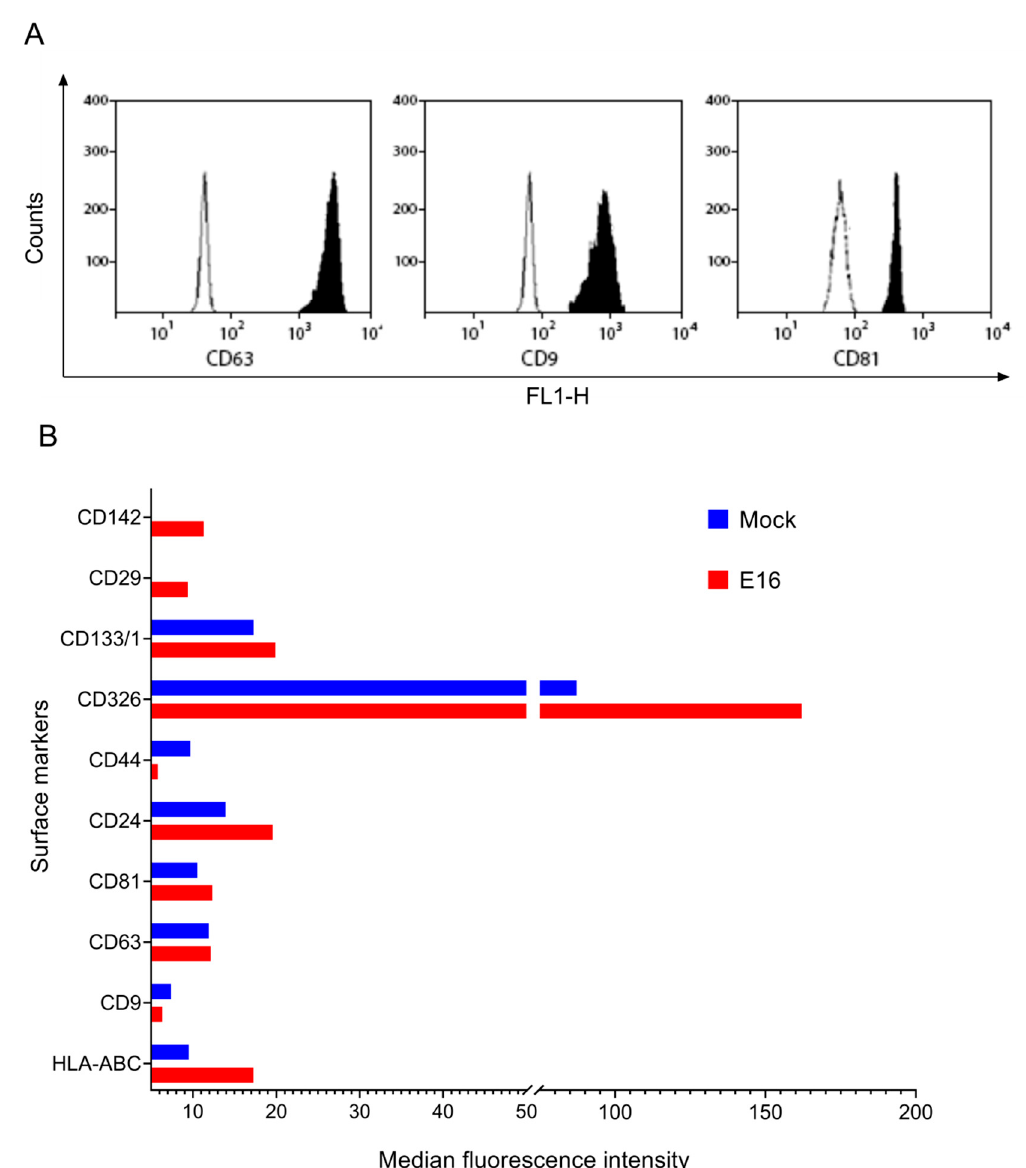
Figure 3. Phenotyping of EndoC- β H1 cell-derived EVs ( A ) Flow cytometer results showing the expression levels of CD63, CD9, and CD81 in EndoC- β H1 cell-derived EVs. Barren areas are isotype control and shaded areas represent positive marker expression. See Figure S2 for complete datasets of all replicates ( B ) Median fluorescence intensities values of selected markers detected in EVs isolated from mock- and E16-infected EndoC- β H1 cells. The figure shows representative data of at least five independent experiments using bead-based multiplex flow cytometry assay. See Figure S3 for complete datasets of all replicates.